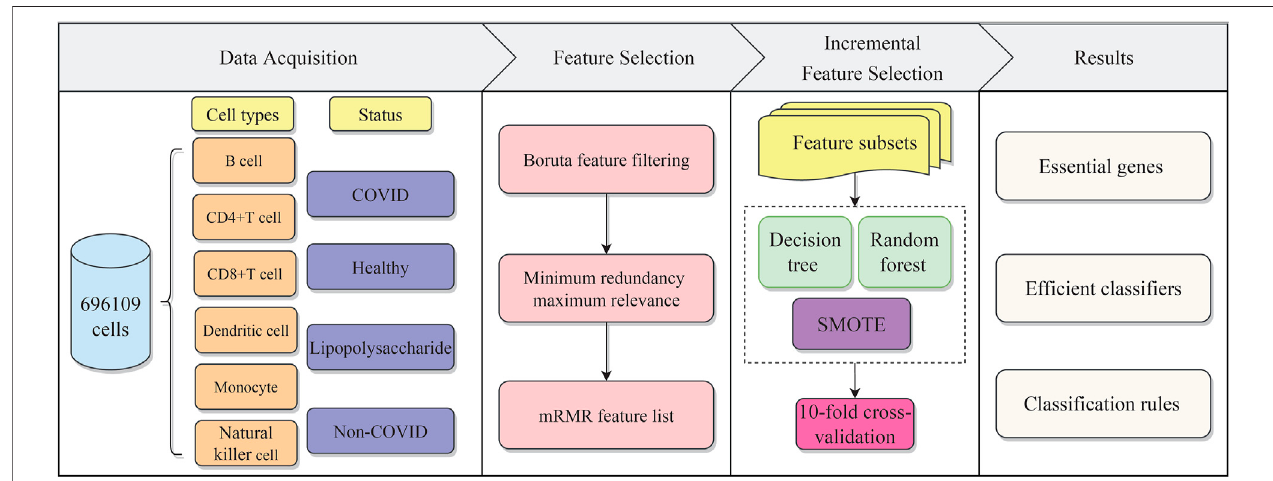
FIGURE1| Flowchartofthewholeanalyticalprocedure.Thesingle-cellpro fi lesofCOVID-19includeBcells,CD4 + Tcells,CD8 + Tcells,dendriticcells,monocytes, and natural killer cells, each of which has various disease statuses, namely, COVID, healthy, lipopolysaccharide (LPS), and non-COVID. The gene features are analyzed by two feature selection methods, namely, Boruta and mRMR. The result feature list is fed into the incremental feature selection (IFS) method to extract essential genes, and construct ef fi cient classi fi ers and classi fi cation